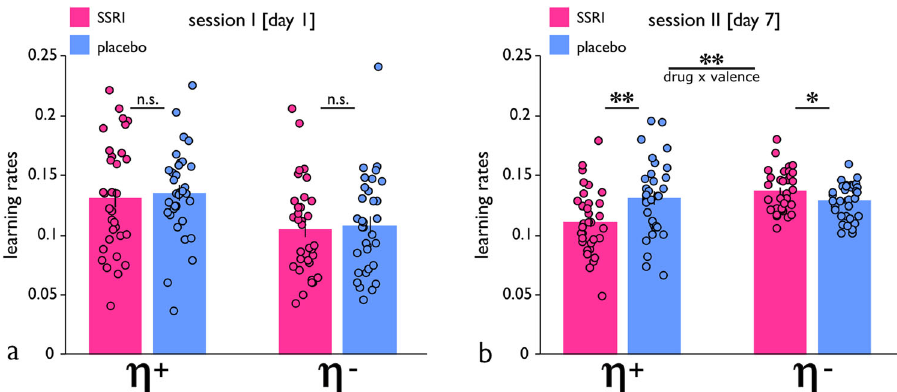
Fig. 3 Learning asymmetry and its serotonergic modulation. a On session I, computational modelling showed learning from reward ( η + ) and learning from punishment ( η − ) was unaffected by drug treatment. b On session II, SSRI treatment had a signi fi cant effect on learning asymmetries, such that it reduced learning from reward ( η + ), and enhanced learning from punishment ( η - ). Note that data simulation showed that an ‘ optimal ’ learning rate for the task, maximizing net reward gained, was in the range of ≈ 0.3 – 0.6 (Supplementary Fig. 2). ** p < 0.01, * p < 0.05, n.s. = not signi fi cant ( p > 0.05). Error bars indicate